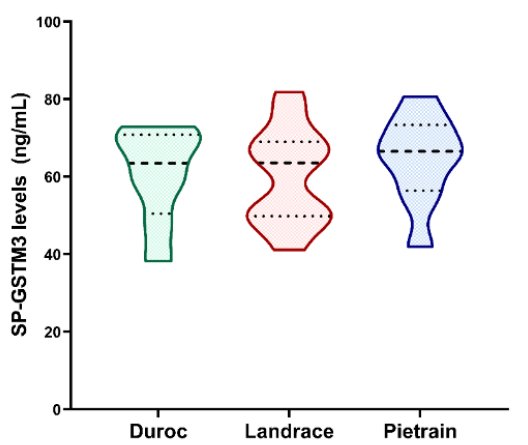
Figure 1. Violin plots showing seminal plasma GSTM3 (SP-GSTM3) concentration levels (ng/mL) and distribution from ejaculates of different pig breeds. Duroc, n = 8; Landrace, n = 13 and Pietrain, n = 9. Dashed line represents the median and dotted lines the 25 and 75% quartiles. No significant differences ( p > 0.05) in SP-GSTM3 concentrations were found between breeds.